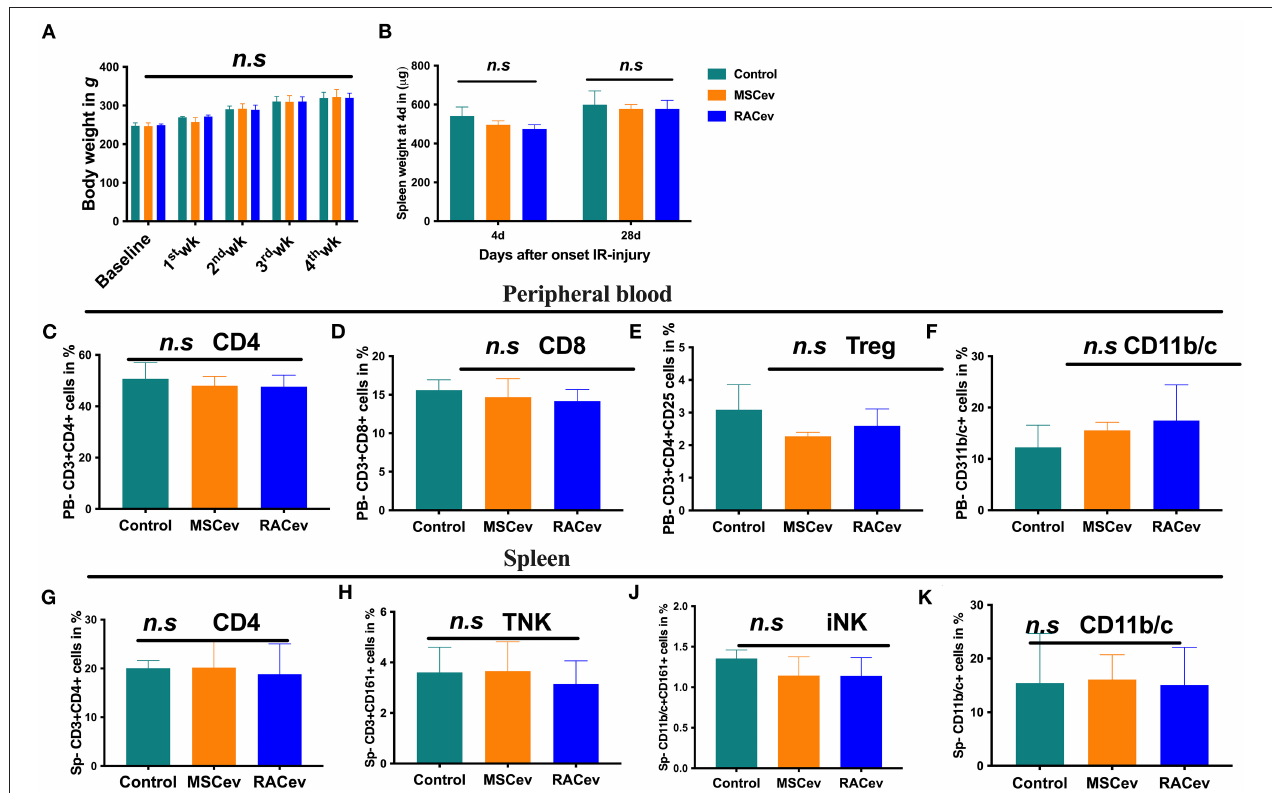
FIGURE 7 | Immunomodulatory effect of RACev. (A) The body weights of all three groups were similar across the study period. (B) Spleen weight mass at days 4 and 28 days after myocardial ischemia reperfusion injury was not different among the three groups. (C–F) Peripheral blood-derived CD4, CD8, Treg, and CD11b/c cells were not elevated, indicating immune tolerance effect of RACev. (G–K) Spleen-derived immune reaction or response biomarkers such as CD4, TNK, iNK, and antigen-presenting cells were evaluated and did not change among the three groups. Statistical significance was determined using the One-way ANNOVA followed by Dunn’s multiple comparisons post-hoc test. The results are presented as mean ± SEM ( n = 8–10 per